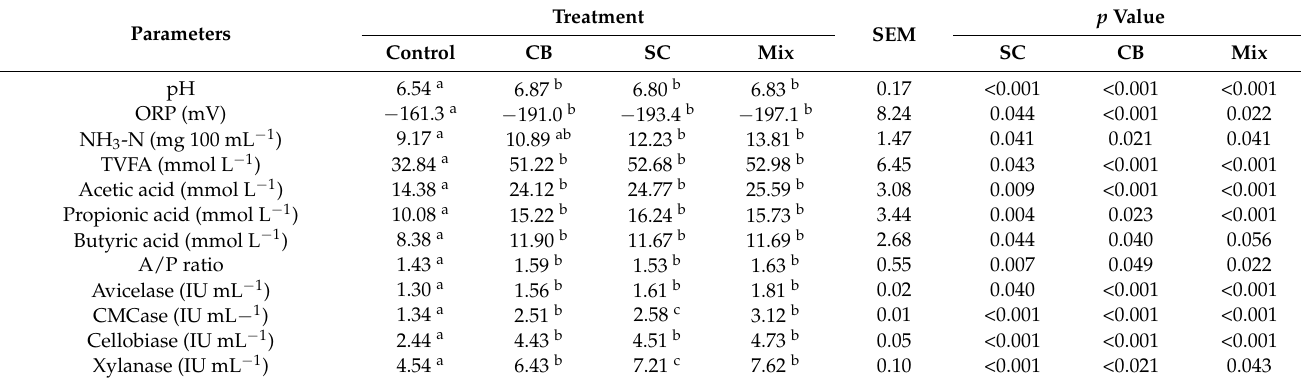
Table 4. The parameters of rumen fermentation and the activities of ruminal cellulolytic enzymes of heat-stressed goats with probiotic supplements.